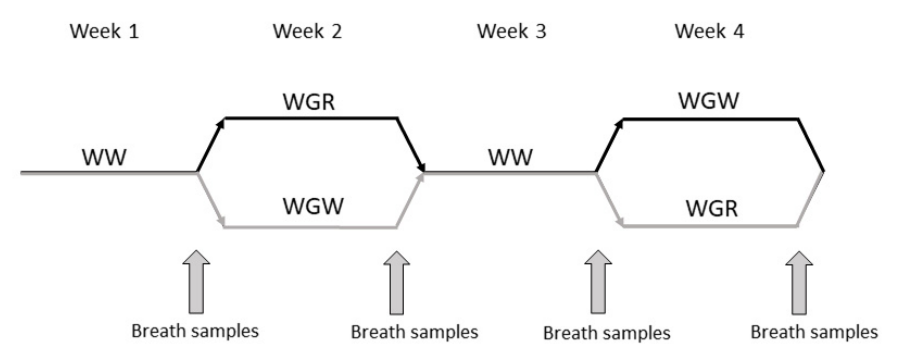
Figure 1. Study design of a randomized crossover manner dietary intervention with 9 participants. WW = control diet containing refined wheat bread; WGR = whole grain rye bread diet; WGW = whole grain wheat bread diet. Exhaled breath and parallel background room air samples were taken at the end of the diet periods.